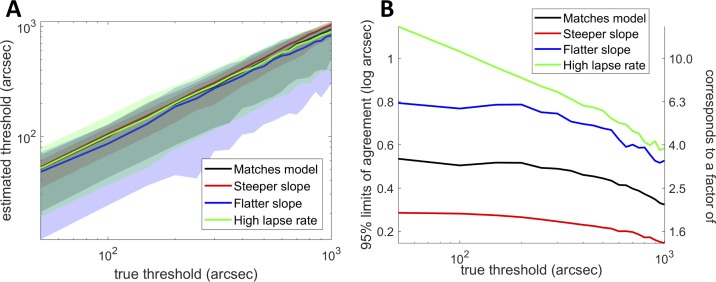
(A) Threshold estimates obtained on a simulated version of ASTEROID for four different example model observers. (B) Ninety-five percent limits of agreement for pairs of threshold estimates from the same four model observers. Model observers differ in their true stereo threshold, indicated by position on the horizontal axis, and in their lapse rate and the steepness of their psychometric function, as indicated by the different colored curves. Black: λM = 0.03, bM = 4.885/log10 arcsec; red: λ = 0.03, bM = 14.654/log10 arcsec; blue: λM = 0.03, bM = 2.931/log10 arcsec; green: λM = 0.1, bM = 4.885. In every case the simulated ASTEROID assumed λ = 0.03, b = 4.885.